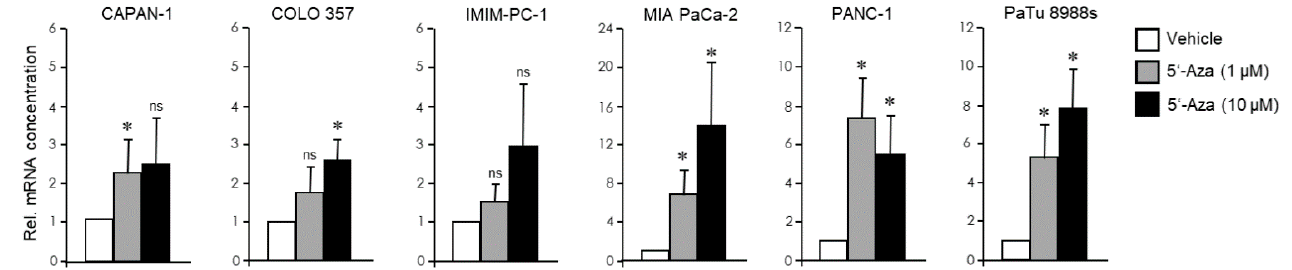
Figure 3. Effect of treatment with 5 (cid:48) -Aza on NEUROG3 activation in PDAC-derived tumor cells with E or QM signatures. The indicated PDAC cell lines were treated with 5 (cid:48) -Aza (1 or 10 µ M), or vehicle, in normal growth medium for 3 d followed by another 3 day incubation period in medium without 5 (cid:48) -Aza. NGN3 expression was analyzed by qPCR. Please note the different scales of the graphs when comparing the 5 (cid:48) -Aza effects among cell lines. Data are plotted relative to vehicle controls and represent the mean ± SD of three (IMIM-PC-1, PANC-1, PaTu 8988s) or four (CAPAN-1, COLO 357, MIA PaCa-2) independent experiments and are plotted relative to control cells set arbitrarily at 1.0. Asterisks (*) indicate significance ( p < 0.05, Wilcoxon test); ns,